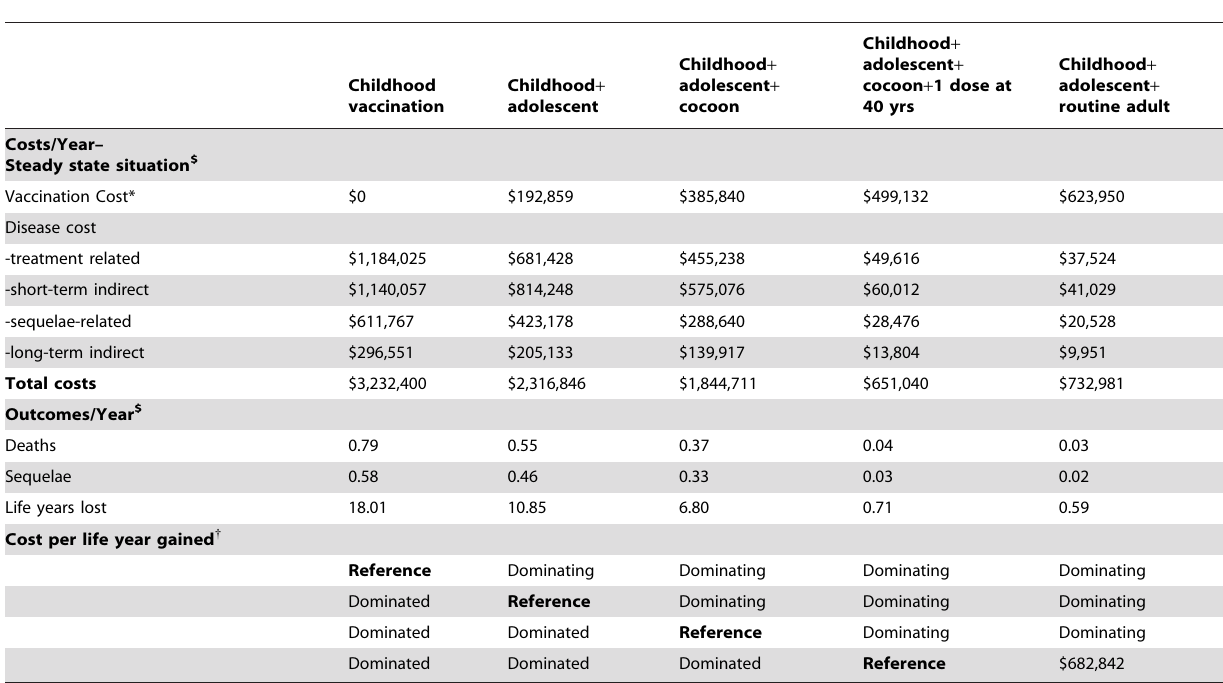
Figure 1. Average annual predicted costs of pertussis and vaccination from 2006 to 2106. doi:10.1371/journal.pone.0006284.g001 Table 4. Cost-effectiveness results in the base